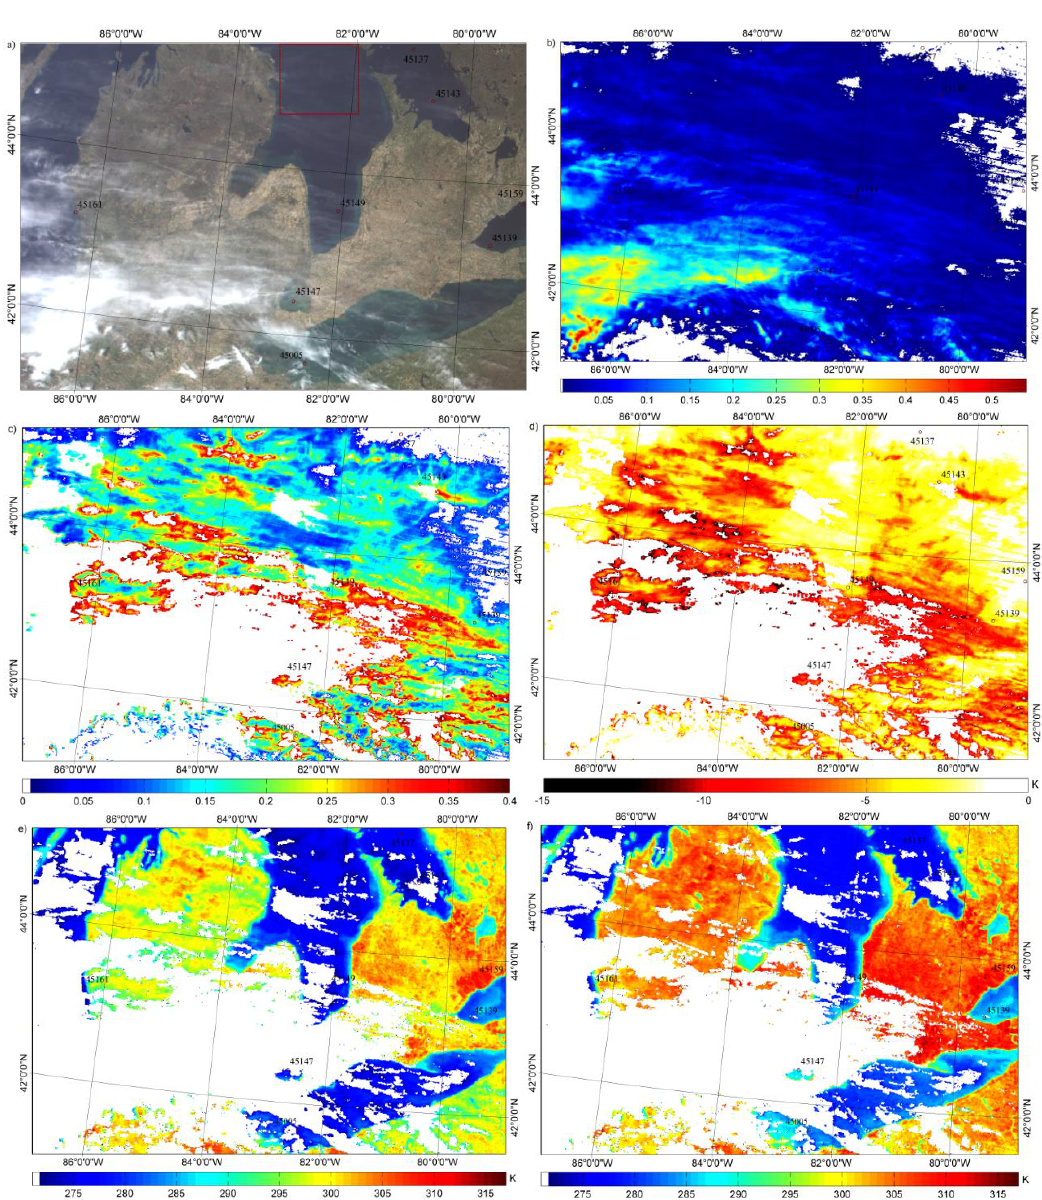
Figure 9. ( a ) Terra/MODIS true color map of the study area, ( b ) ICBR in MOD06_L2, ( c ) COD at 0.55 μm where the COD is greater than 0.02 and less than 0.4, the cirrus reflectance flags are “cirrus”, and the corresponding LSTs in MOD11_L2 are available, ( d ) LST errors estimated using the proposed extension algorithm ( k * COD ), ( e ) MOD11_L2, and (f) MOD11_L2 corrected with k * COD